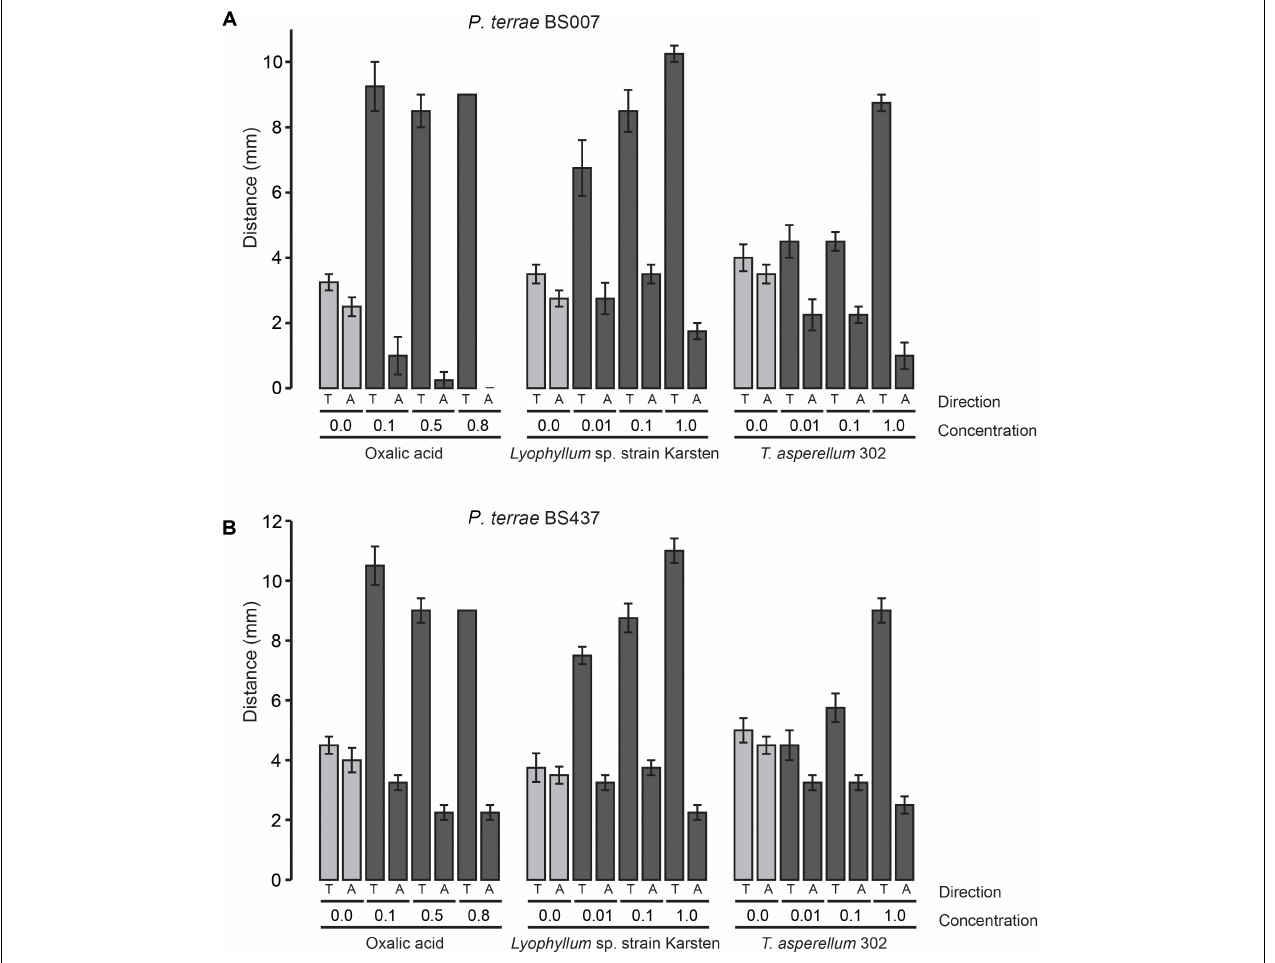
FIGURE 2 | Chemotactic (swimming) behavior of P. terrae strains BS007 and BS437 toward oxalate and exudates of Lyophyllum sp. strain Karsten and T. asperellum 302 on 0.25% (w/v) M9 medium. (A) The response of P. terrae BS007 to either oxalate or exudates of both fungal strains. (B) The response of P. terrae BS437 to either oxalate or exudates of both fungal strains. The Y -axis represents distance in mm, whereas the X -axis shows the direction of taxis (toward denoted by “T” and away denoted by “A”) and concentration of oxalate or levels of exudates. Data are representative of four biological replicates.